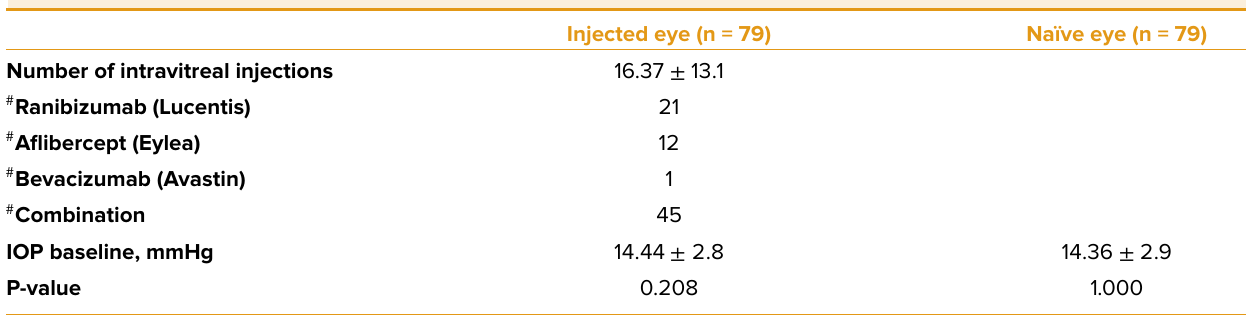
Table 1. Summary of clinical data